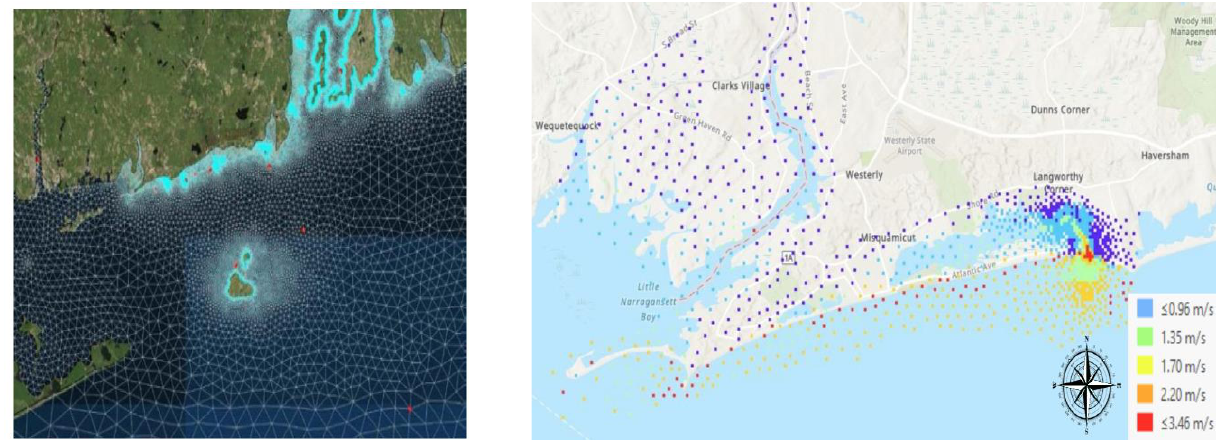
Figure 4. ADCIRC grid system ( left panel) used to predict the 100 yr storm event for SLR values of 0, 3.2, and 6.6 ft (simulations were performed by Soroush Kouhi, 2019) and the model predicted currents for the study area for the 100 yr storm, 3.2 ft SLR case ( right panel).